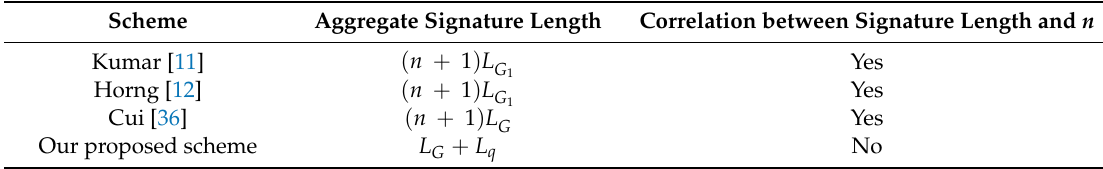
Figure 5. The comparison of aggregate verification cost in IoTs. Table 9. The comparison of communication cost in IoTs.